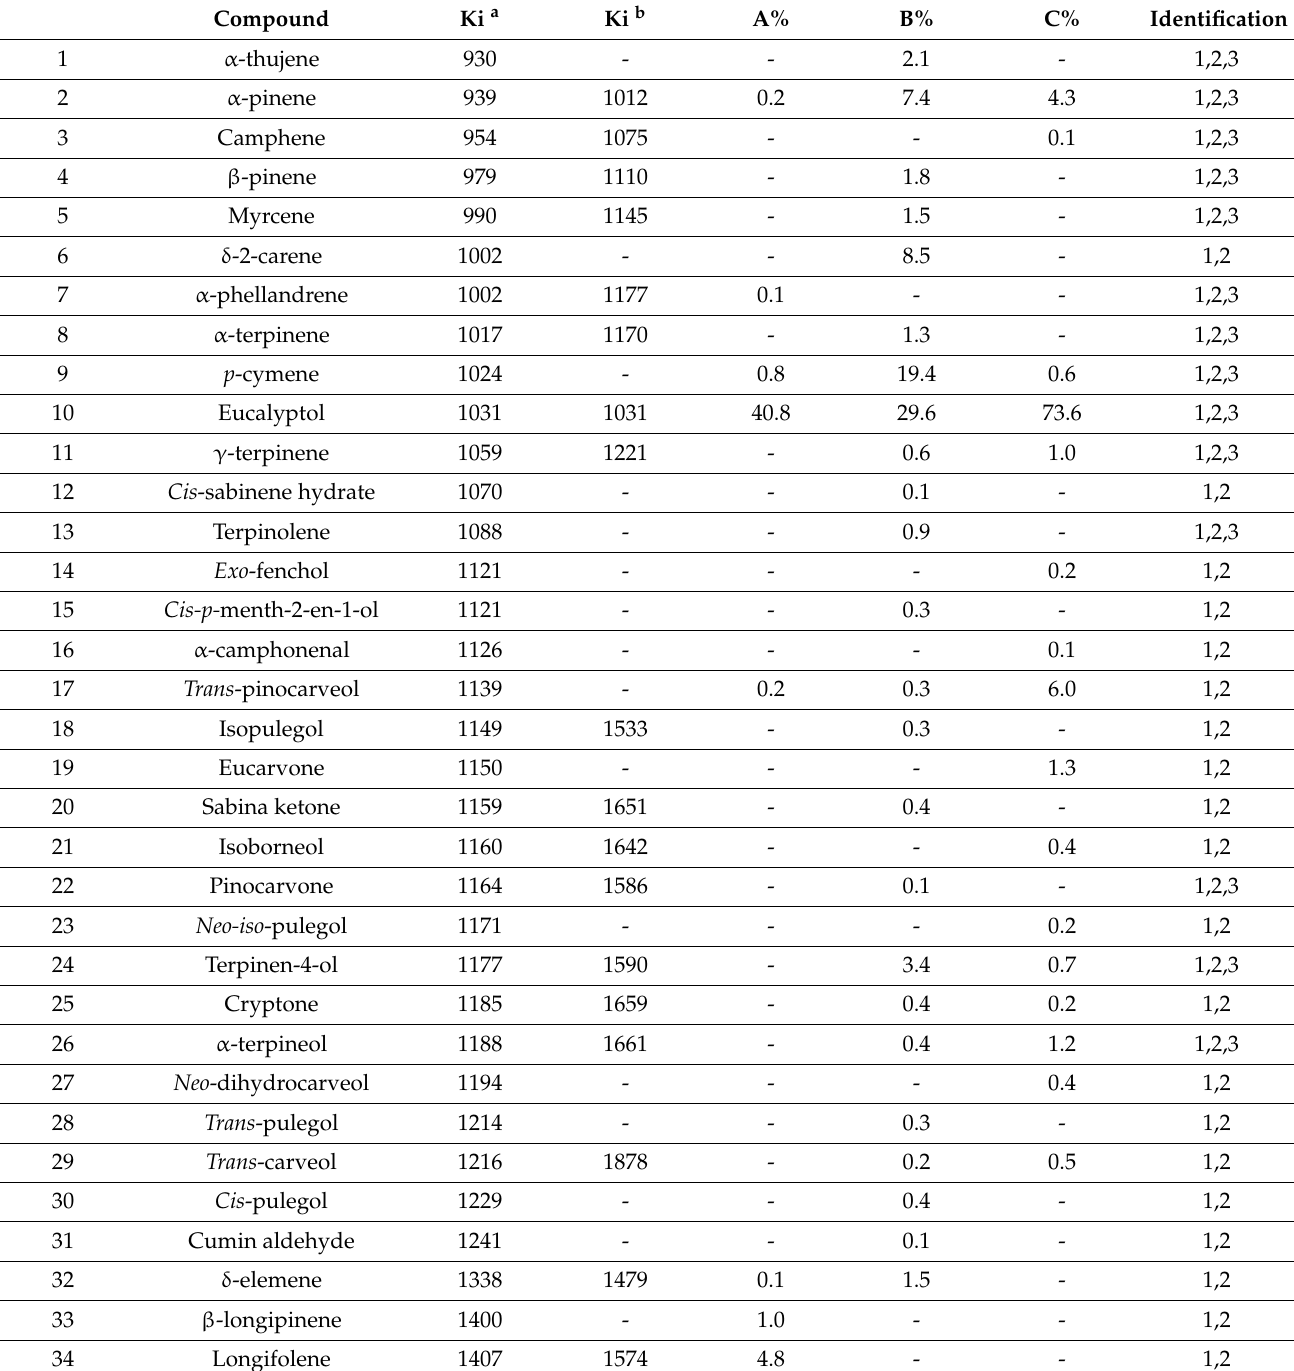
Table 1. Chemical composition (%) of essential oils of E. occidentalis (A), E. striaticalyx (B) and E. stricklandii (C)